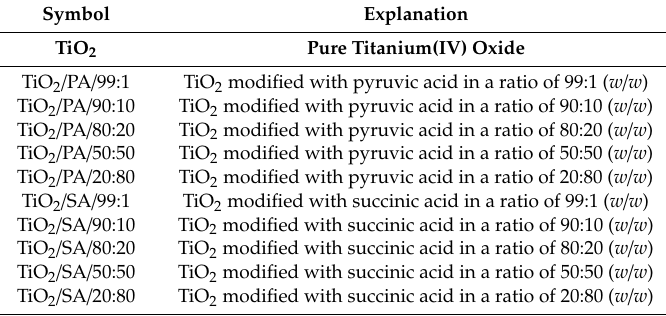
Table 3. Symbols of the